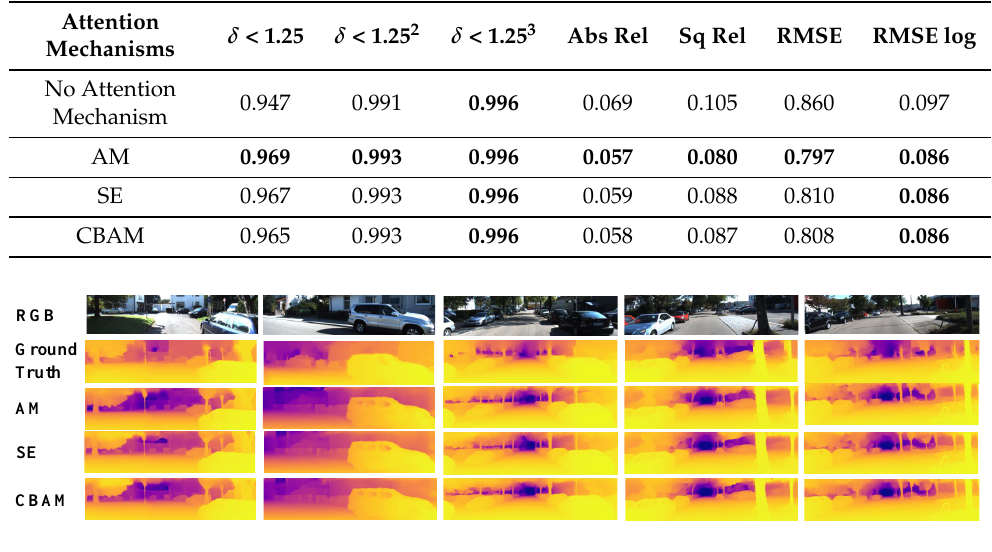
Figure 6. A visualization of the results from our foreground depth prediction model using the different attention mechanisms: AM, SE, and